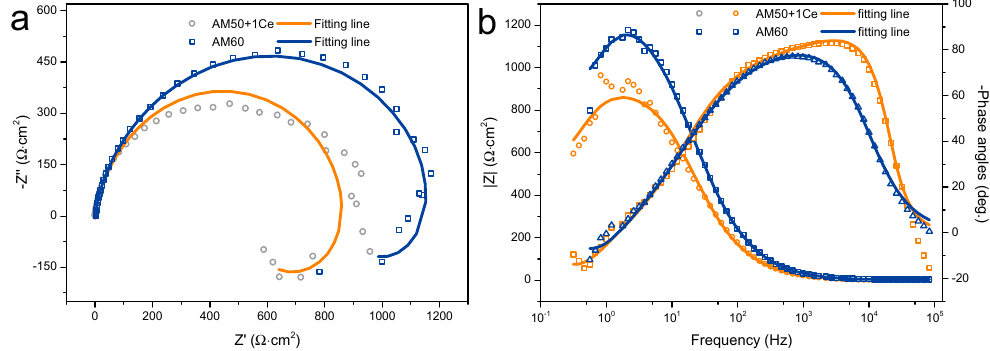
Figure 12. The Nyquist ( a ) and Bode plots ( b ) of EIS data of HPDC AM50 + 1Ce and AM60 magnesium alloys in 3.5 wt% NaCl solution.